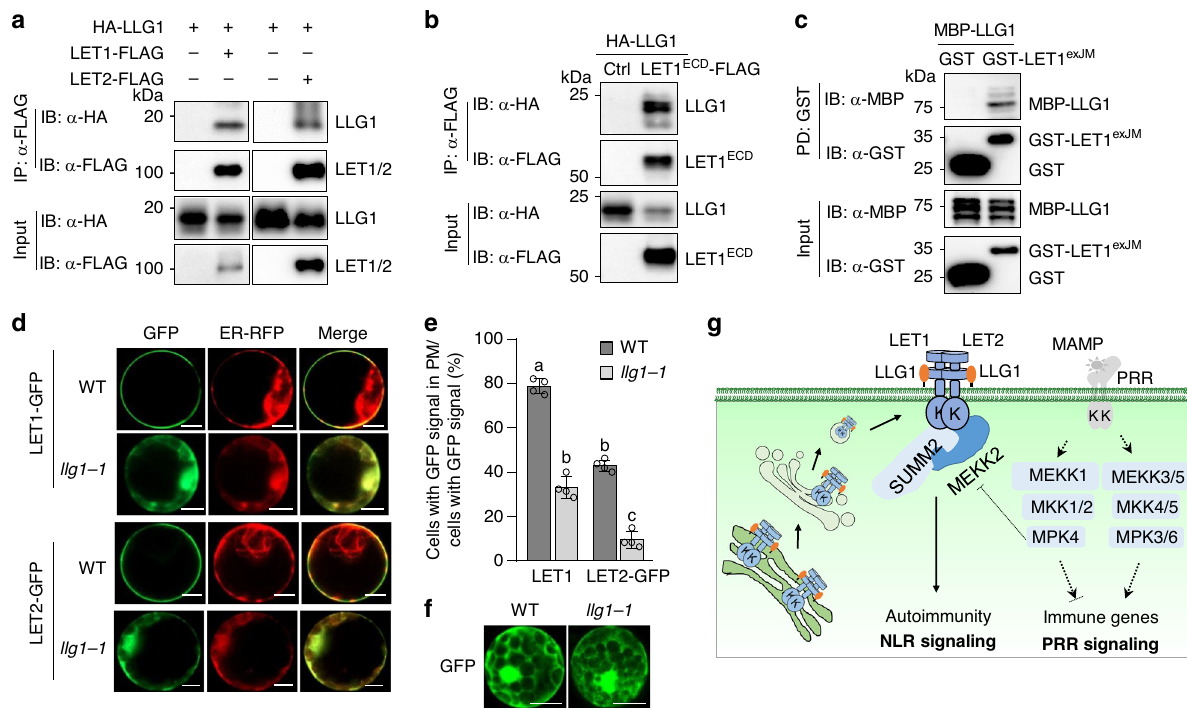
Fig. 7 LLG1 interacts with LETs and facilitates their plasma membrane localization. a LLG1 interacts with LET1 and LET2/MDS1. HA-LLG1 was co- expressed with Ctrl, LET1-FLAG or LET2-FLAG, in Arabidopsis protoplasts. Total proteins were immunoprecipitated with α -FLAG af fi nity beads and then immunoblotted by an α -HA or α -FLAG antibody (top two panels). Immunoblots using total proteins before immunoprecipitation are shown as protein inputs (bottom two panels). b LLG1 interacts with the LET1 extracellular domain (LET1 ECD ) in Arabidopsis protoplasts. The assay was performed as in a . c LLG1 directly interacts with LET1 extracellular juxtamembrane domain (LET1 exJM ) in vitro. MBP-LLG1 (without signal peptide), GST-LET1 exJM and GST fusion proteins isolated from E. coli were used for an in vitro pull-down assay using glutathione agarose beads followed by immunoblotting using an α -MBP or α -GST antibody (top two panels). Input proteins were immunoblotted by an α -MBP or α -GST antibody before pull-down (bottom two panels). d Representative subcellular localization patterns of LET1-GFP and LET2-GFP proteins in WT and llg1-1 protoplasts. The images were taken under laser scanning confocal microscopy at 12 h after transfection. ER-RFP was used as an ER marker. Scale bar, 50 μ m. e The percentage of LET1-GFP and LET2-GFP signals in PM in WT and llg1-1 . The ratio of protoplasts with only PM-localized LET-GFP signals to the total protoplasts with GFP signals was measured over 100 fl uorescent cells. The protoplasts without clear PM-localized GFP signals show ER-localized GFP signals. The data are shown as mean ± SE of four independent transfections ( n = 4). P = 4.40 × 10 − 9 (column 1 and 2) and P = 1.39 × 10 − 7 (column 3 and 4). The different letters indicate the signi fi cant difference determined by one-way ANOVA followed by the Tukey test ( P < 0.001). f Similar localization of GFP in WT and llg1-1 protoplasts. The images were taken at 12 h after transfection. Scale bar, 100 μ m. g A model of LET1-LET2-LLG1 complex in cell death regulation. MAMP-activated MEKK1-MKK1/2- MPK4 cascade regulates PRR-mediated immune signaling, and SUMM2-mediated autoimmunity via suppressing MEKK2 expression. Two Cr RLK1Ls, LET1 and LET2/MDS1, together with GPI-anchored protein LLG1, form a trimeric complex to modulate SUMM2 activation. LLG1 likely functions as a co-receptor of LET1/2 and assists LET1/2 protein maturation and delivery from endoplasmic reticulum (ER), Golgi to plasma membrane (PM). The above experiments were repeated three times with similar analyzed the subcellular localization of LET1 fused with green fl uorescent protein (LET1-GFP) and LET2-GFP in protoplasts of WT and the llg1-1 mutant. In WT protoplasts, the majority of cells with LET1-GFP signals (~80%) displayed PM localization (Fig. 7d, e), whereas in llg1-1 , only ~35% of cells with LET1-GFP